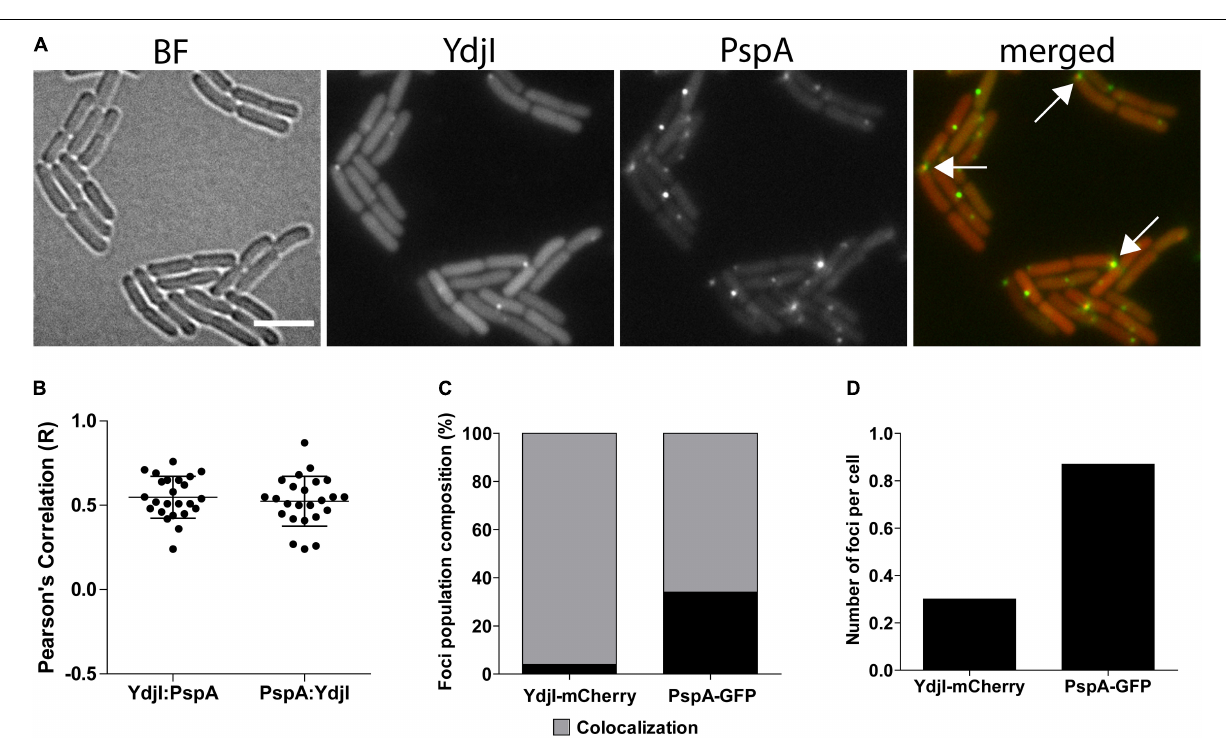
FIGURE 3 | Co-localization analysis of PspA and YdjI proteins. (A) Micrographs showing exponentially growing cells of expressing YdjI-mCherry2 and PspA-GFP in alkali stress condition (15 mM NaOH). Arrows indicate co-localized foci. Scale bar: 4 µ m. (B) Scattered dot plots of Pearson’s correlation ( R values) assessed by Coloc-2 plugin from FIJI. Red to green (YdjI:PspA) and green to red (PspA:YdjI) co-localization analysis are shown. Error bars represent mean and standard deviation of values calculated for 24 cells. (C) Foci population composition in percentage of cells ( n = 1650). (D) Ratio of total number of foci in each channel per total of cells ( n =